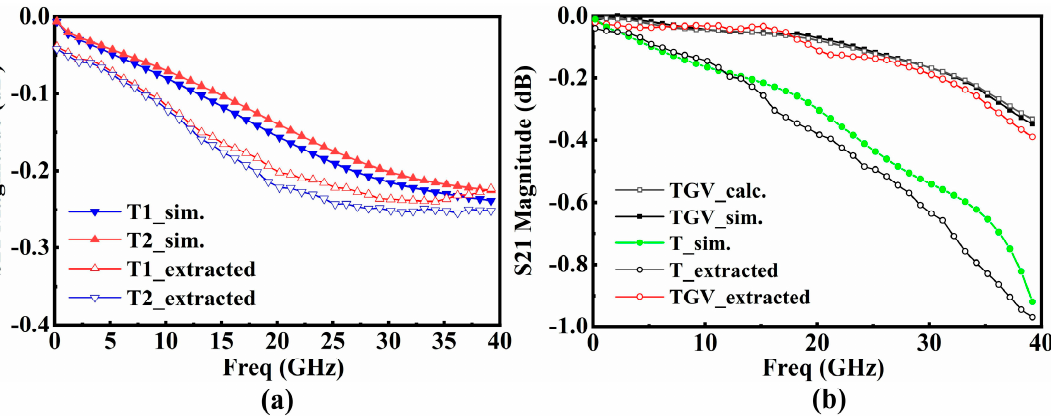
Figure 7. Comparison of the insertion losses measured and extracted of the TGVs with the simulation results. ( a ) Simulation model of the CPW series without TGVs, ( b ) The CPW series simulation model incorporating TGVs.